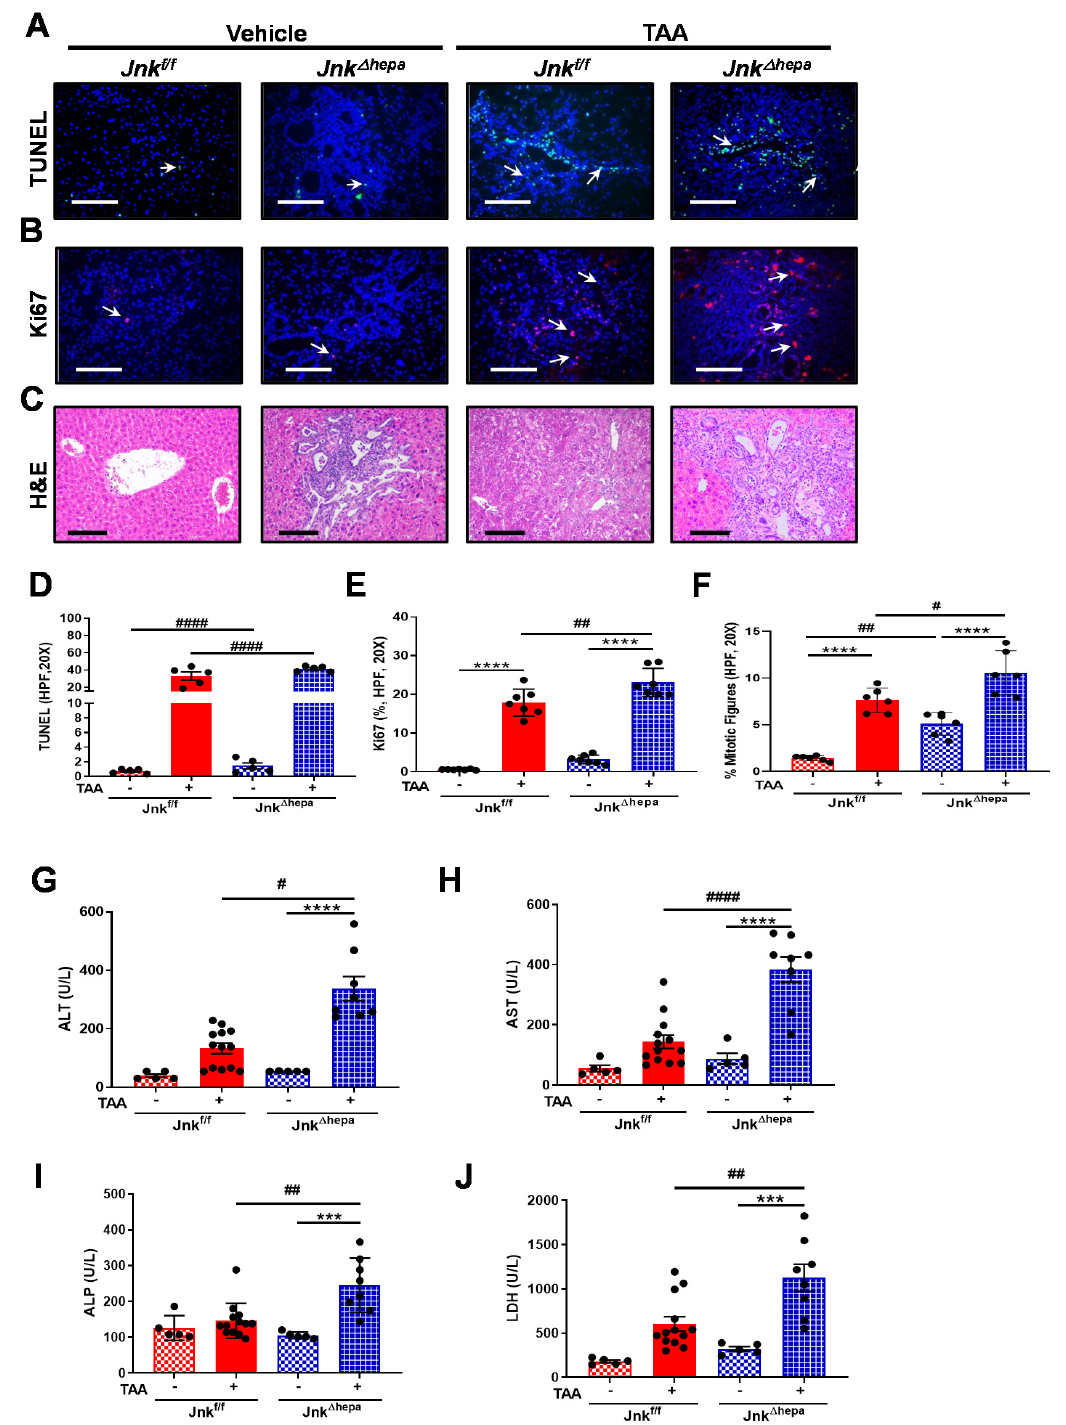
Figure 6. Jnk ∆ hepa mice display extensive hepatocellular and cholangiocellular injury in response to TAA. ( A ) Cell death was evaluated using TUNEL staining of liver tissue sections from TAA-treated Jnk f/f and J nk ∆ hepa mice. Arrows ( → ) indicate TUNEL positive cells. Scale bars, 50 µ m. ( B ) Expression of Ki67 was evaluated by IF staining. Scale bars, 50 µ m. ( C ) Liver histopathology was analyzed by H&E staining in each experimental group. Positive TUNEL ( D ) , Ki67 cells ( E ) and frequency of mitotic figures ( F ) were analyzed by ImageJ and graphed. ( G – J ) Analysis of serum levels of ALT, AST, ALP and LDH was assessed. Data were represented as the mean ± SEM and graphed ( n = 5–13 mice per group; # p < 0.05; ## p < 0.01; *** p < 0.001; ****/#### p < 0.0001).